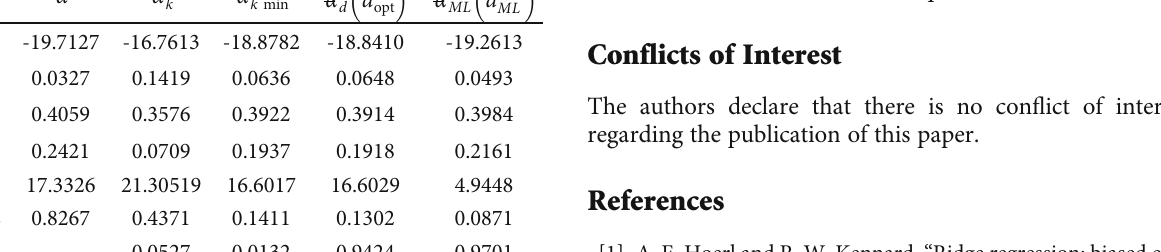
Table 10: The regression output.